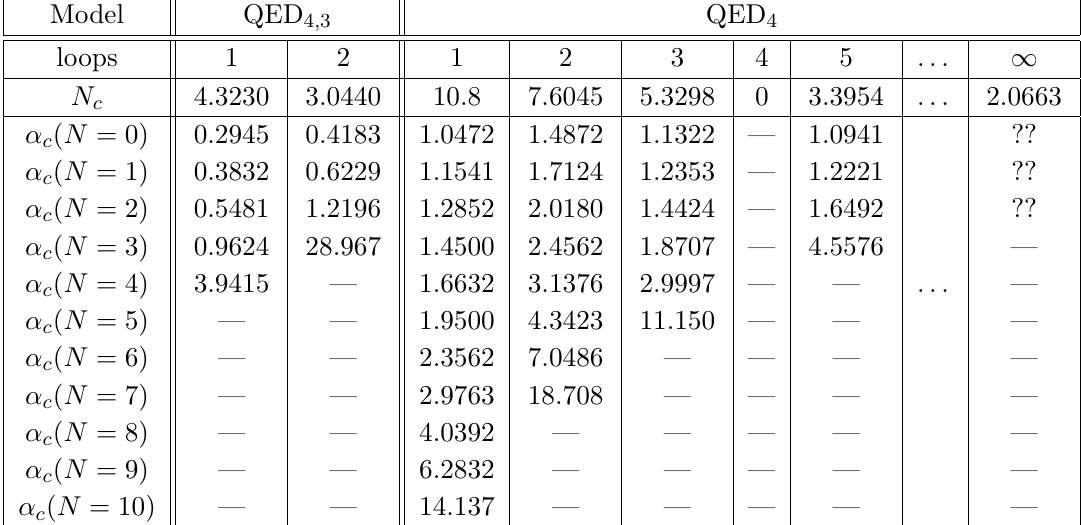
— and QED , computed from (4.11) to- 4 , 3 4